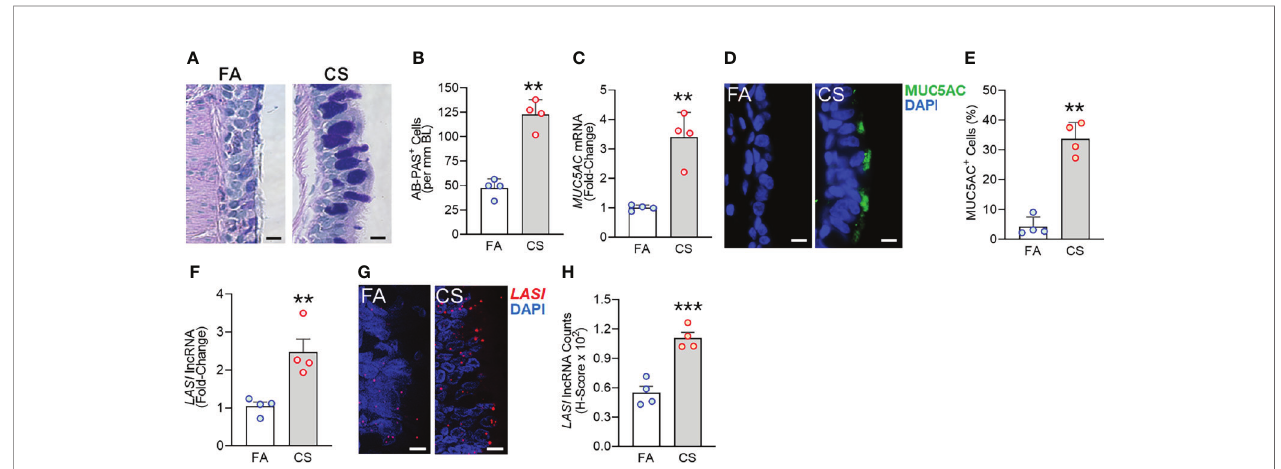
FIGURE 1 | Chronic cigarette smoke (CS) exposure of cynomolgus macaques results in goblet/mucous cell hyperplasia that is strongly associated with increased LASI lncRNA expression in bronchial airways. Bronchial airway tissues from C. macaques exposed to mainstream CS or control fi ltered-air (FA) for 27 weeks as reported recently (12) were analyzed. (A) Representative histomicrographs of bronchial tissue sections showing AB-PAS-stained goblet/mucous cells in CS- and FA- exposed macaques, scale – 10 µm. (B) Number of AB-PAS+ cells quanti fi ed per mm of basal lamina (BL) in each group. (C) Relative quantity of secretory mucin MUC5AC mRNA in CS-exposed macaques compared to FA-controls as determined by qPCR. (D) Representative micrographs of bronchial tissue sections showing MUC5AC immunopositivity in CS- and FA-exposed macaques, scale – 5 µm. (E) Percentage of MUC5AC+ cells over the total epithelial cells quanti fi ed for each group. (F) Relative quantity of LASI lncRNA in CS-exposed macaques versus FA-controls as determined by qPCR. (G) Representative micrographs showing LASI lncRNA expression in FA and CS macaques as determined by FISH, scale – 5 µm. (H) Quanti fi cation of LASI lncRNA expression in bronchial epithelial cells of each group as determined by H-score analysis described earlier (11). Data shown as mean ± SEM; n=4/gp and analyzed by student ’ s t-test; ** p <0.01; *** p